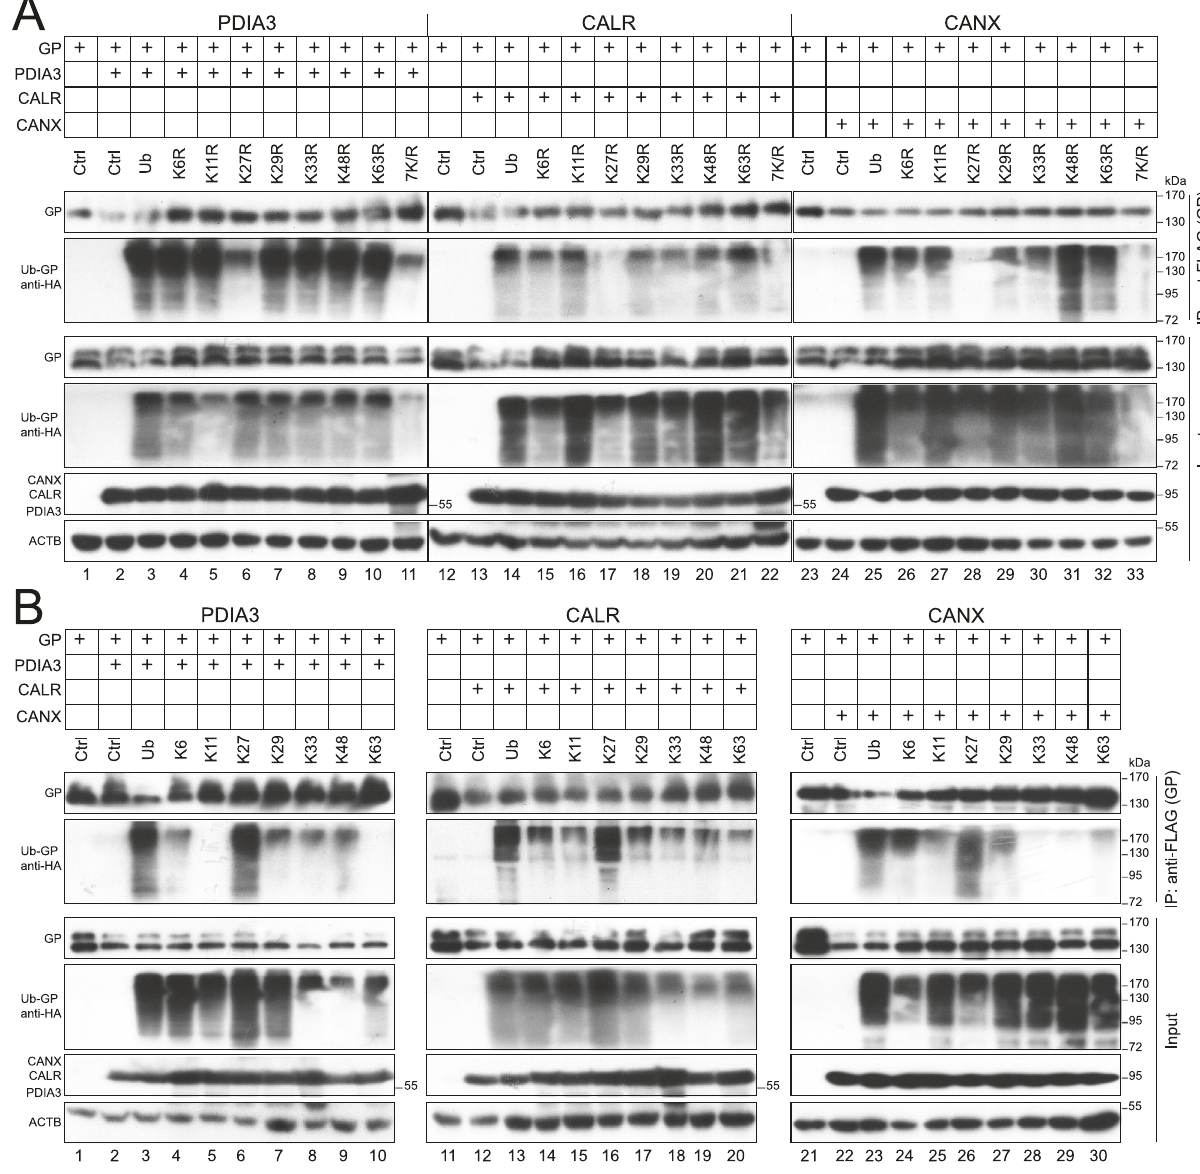
Fig. 7 | EBOV-GP 1,2 (GP) is polyubiquitinated with K27-linked ubiquitin chains. A GP was expressed with Ub or its mutants bearing indicated single K-to-R muta- tion, and PDIA3, CALR, or CANX, in HEK293T cells. GP proteins were immunopre- cipitatedand GP polyubiquitination wasanalyzedby WB. B GP wasexpressed